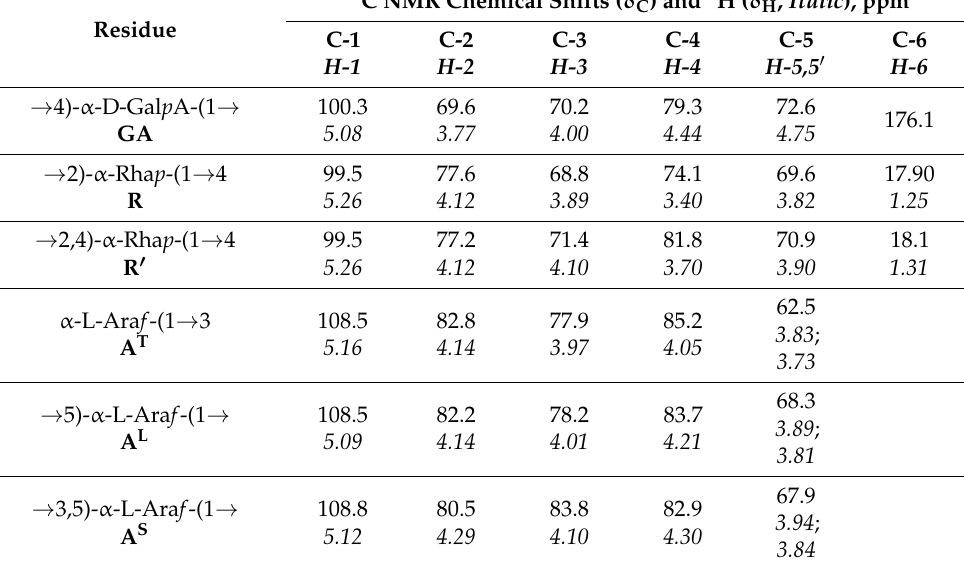
Figure 5. Parts of 1 H, 13 C HSQC spectrum of the SO1-3 . The corresponding parts of the 1 H and 13 C NMR spectra are shown along the X and Y axes, respectively. Arabic numerals refer to the carbon atoms in the residues, as designated in Table 2. Table 2. Chemical shifts of the signals in the 1 H and 13 C NMR spectra of the SO1-1 , SO1-2 and